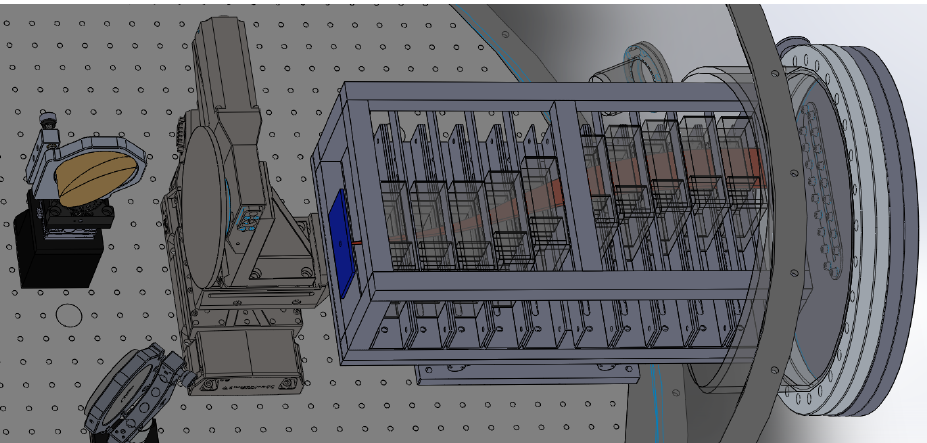
Figure 1. Energy selector made of permanent magnets inside the L2A2 target chamber. The pinhole collimator is highlighted in blue; proton trajectories are sketched in